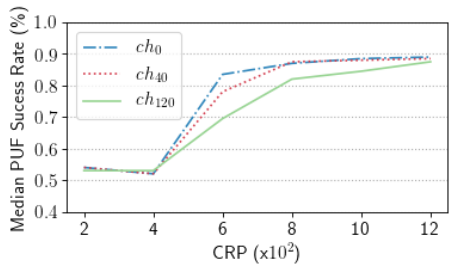
(a) Median PUF success rate using different refer- ence challenges. Figure 7: Comparison between decoding with a single reference challenge and decoding with multiple challenges and creating the mean